Question: What style of plot is this figure drawn as?
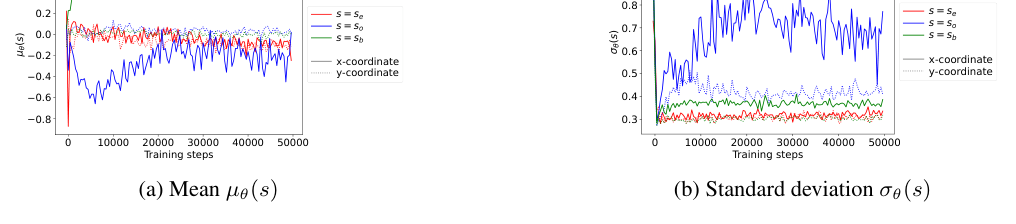
Answer: line